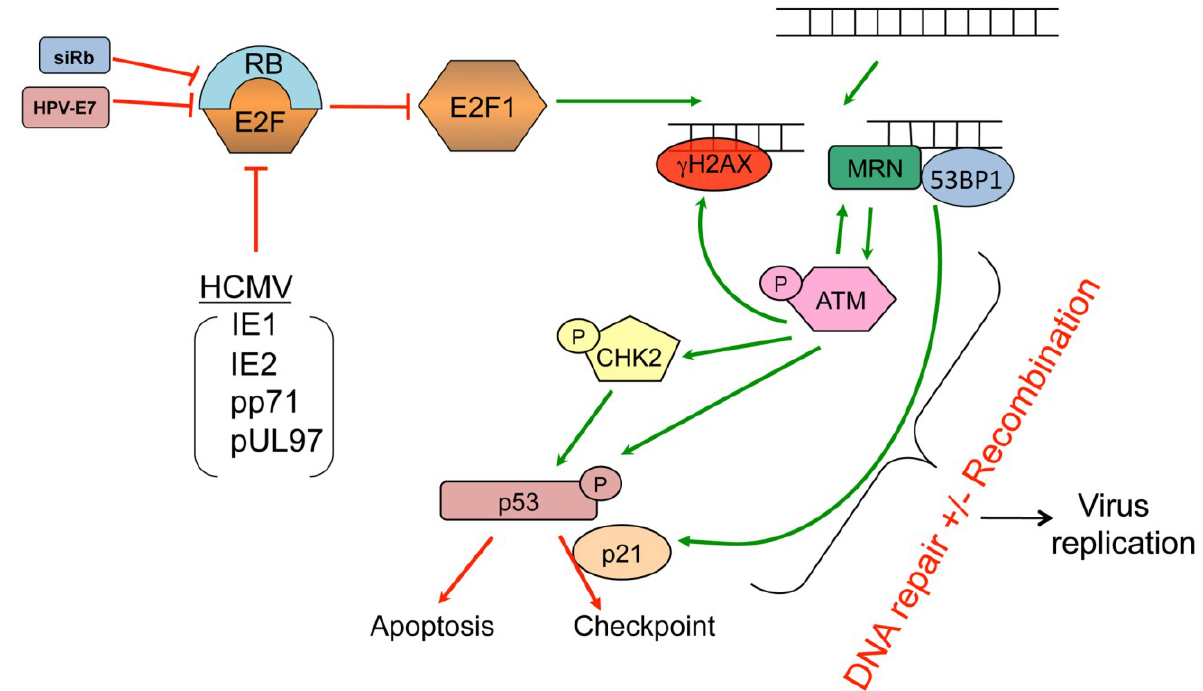
Figure 3. Model of the host DNA damage response induced by HCMV